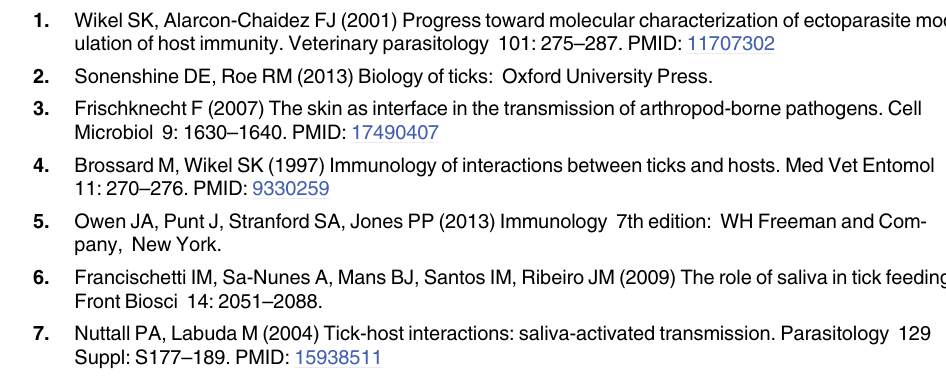
S4 Fig. Effect of a tick bite and intradermal inoculation at 1 h pi in pig skin with SWC3/ SC172 cell labelling. (A) Tick bite. (B) Intradermal inoculation. Two types of tissue lesion were observed. The first was characterized by an area delimited by tissue disruption, collagen disruption and more abundant SWC3/CD172 cell labelling than in healthy tissue (yellow arrows). The second was sometimes observed inside the first, consisting of more intensive damage with more abundant haemorrhage and SWC3/CD172 cell labelling (red arrows). Most of the TICK biopsies presented both areas. However, statistical model analyses were only per- formed on the disrupted area indicated in the photo by the yellow arrows. Biopsies in the sam- ples with tick bites were performed to a depth of 550,0 μ m (n = 14 biopsies on 7 pigs), unlike the inoculated biopsies which were performed to a depth of 1052.8 ± 511.4 μ m (n = 23 biopsies on 14 pigs). S5 Fig. Histological slice of parotid lymph node, inoculation side, at 48 h pi. (A) Parotid lymph node from inoculation side for pigs receiving a high ASFV dose and tick salivary gland extract. (B) Parotid lymph node from inoculation side for pigs receiving a high ASFV dose alone. Merging of histological slice labelled in red with S100-Ab (IgG1, interdigitating dendritic cells, Clone SH-B1, Sigma) [18] and in green with